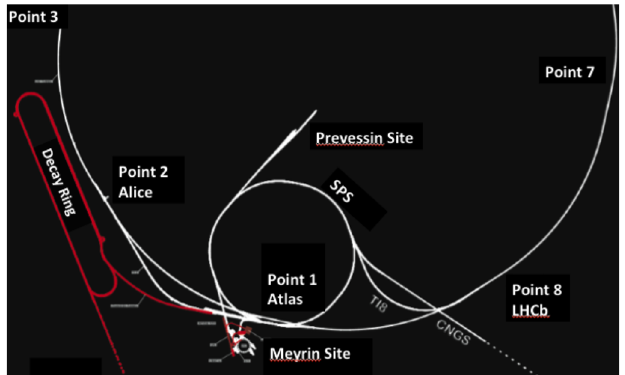
FIG. 2. The CERN beta beam directed to Fréjus, the inclination angle of the decay ring is 0.6° for a neutrino beam pointing at the Fréjus detector. It is placed close to point 2 of the LHC, of which parts can be seen in the figure, using parts of the extraction lines from the